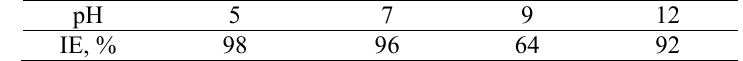
Table 4. Influence of pH on the IE, Cl - = 120 ppm, SM = 50 ppm, Zn 2+ = 0 ppm, Immersion period = one